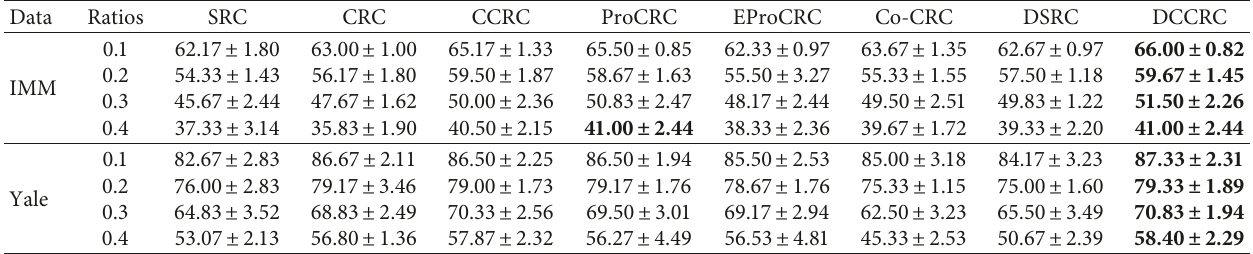
Figure 6: The testing images with the random block occlusions from one class. (a) IMM. (b) Table 5: The classification accuracies (%) of the competing methods with the corresponding standard deviations under the situations of the random block occlusions.